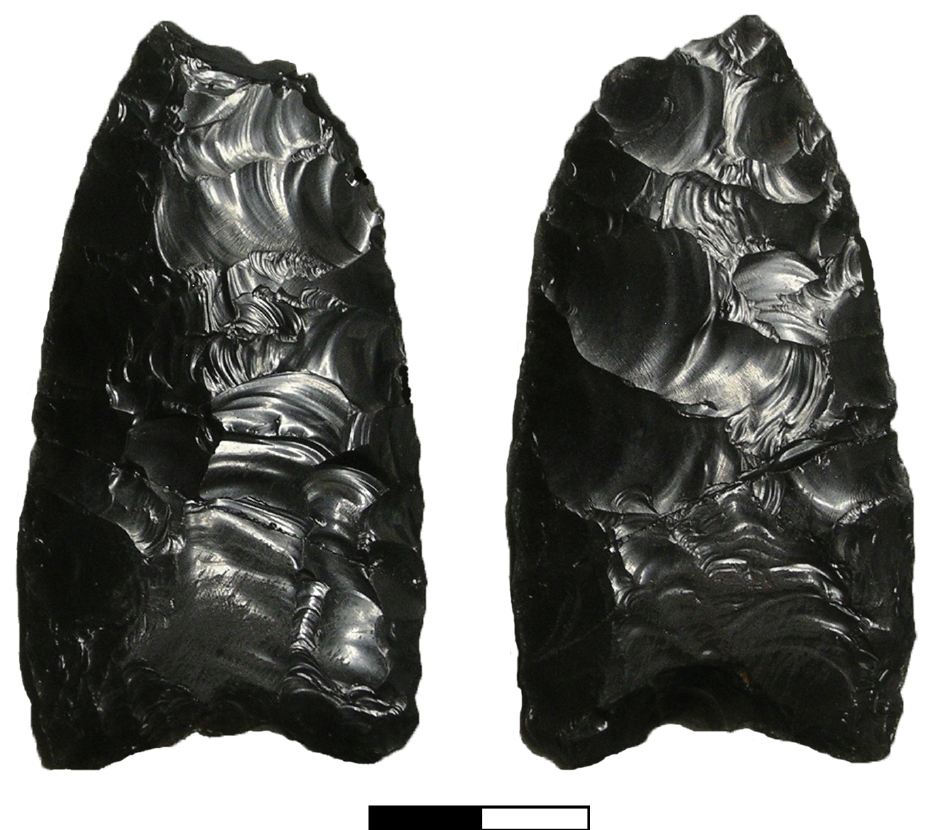
Figure 2. One of the Clovis fluted points from the Hoyt site. This specimen was the first to display evidence of hafting adhesive in the scratches or striations on the fluted areas of both faces (image after Slade 2016). The scale bar is 2cm wide (in 1 cm